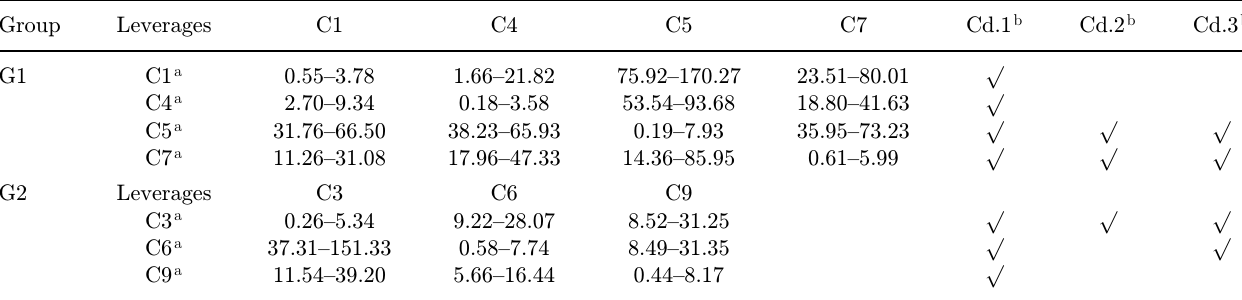
a Raw i represents the ranges of each L b Three conditions used for discrimination.